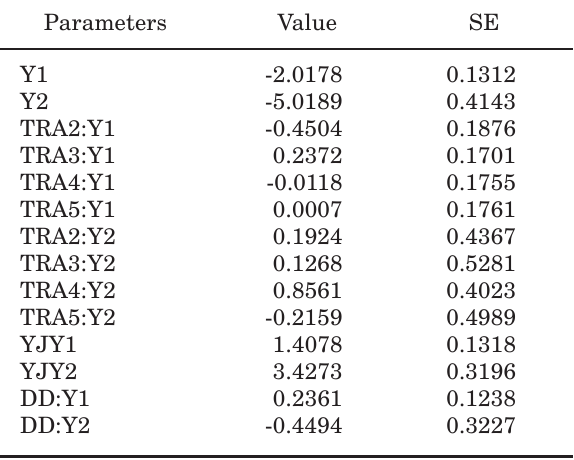
Table 2. Values of the estimated parameters. The pa- rameter name, the estimated value and the standard error (SE) are shown from left to right for the model without